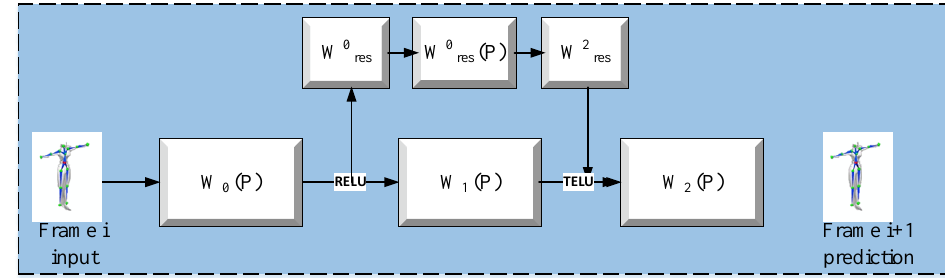
Figure 7. Transfer learning for motion style transfer from motion-captured